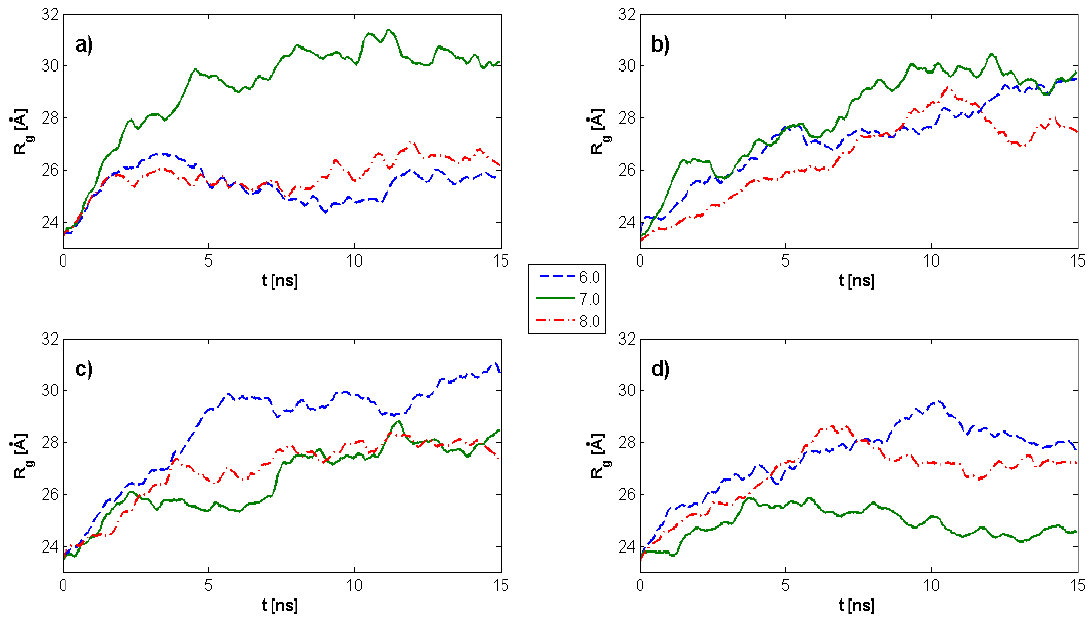
Figure 3. Time evolution of the HA radius of gyration as a function of pH values and dipalmitoylphosphatidylcholine (DPPC) concentration. ( a ) k PL : HA = 0; ( b ) k PL : HA = 1:8; ( c ) k PL : HA = 1:5; ( d ) k PL : HA = 2:7. The legend indicates pH values.